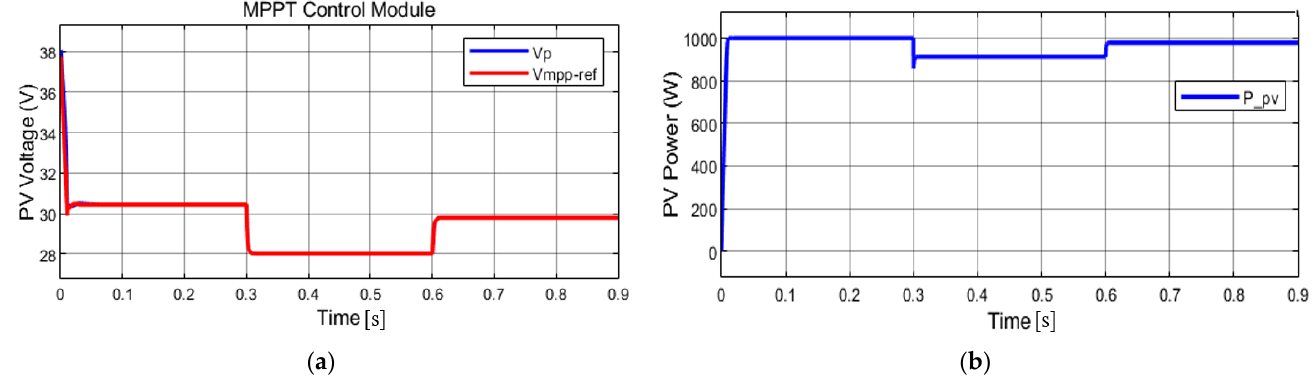
Figure 15. DC link voltage regulator module and current controller module performances with backstepping approach for constant temperature case: ( a ) DC link voltage; ( b ) grid current magnitude; ( c ) grid voltage waveform V g (V) and current waveform where gain is 10 × Ig ( A ) .